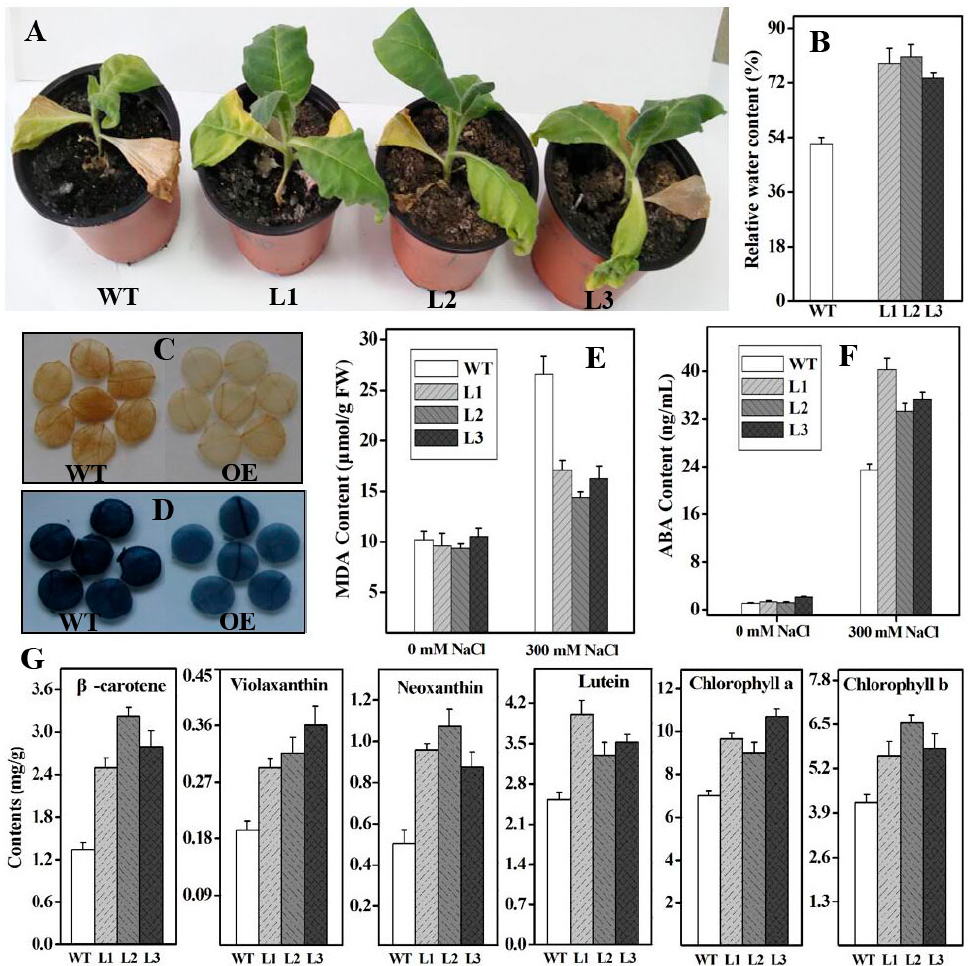
Figure 7. Effects of salt treatment on the T 1 generation of Nt β -LCY1 OE transgenic